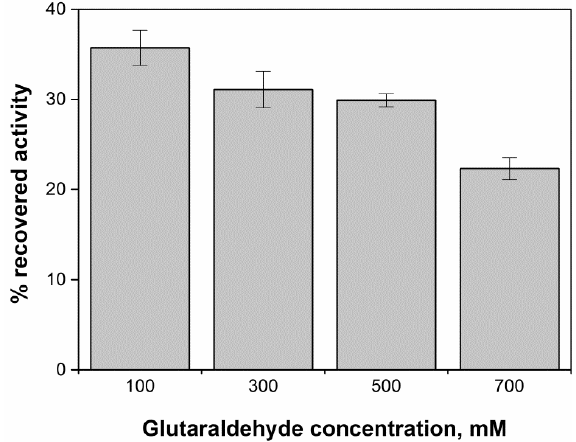
Figure 8. Effect of glutaraldehyde concentration on the recovered activity of CLEAs synthesized in the presence of polyethyleneimine (PEI). Synthesis conditions: PEI/enzyme mass ratio of 1:1 (30 min of gently stirring at 25 ◦ C), addition of the magnetic nanoparticles DCNP-N to a DCNP-N/amyloglucosidase mass ratio of 1:1, precipitation with ethanol (volume ratio enzyme solution in 100 mM phosphate buffer pH 7.00 to ethanol of 1:9), crosslinking with glutaraldehyde concentrations ranging from 100 to 700 mM. Precipitation and crosslinking steps were performed under static conditions in an ice bath. Activity of immobilized amyloglucosidase was measured with 1% ( w / v ) dextrin in 50 mM sodium citrate buffer pH 4.5, 10 min reaction at 55 ◦ C under 900 rpm stirring. Values are shown as the mean of duplicate experiments ± s.d.